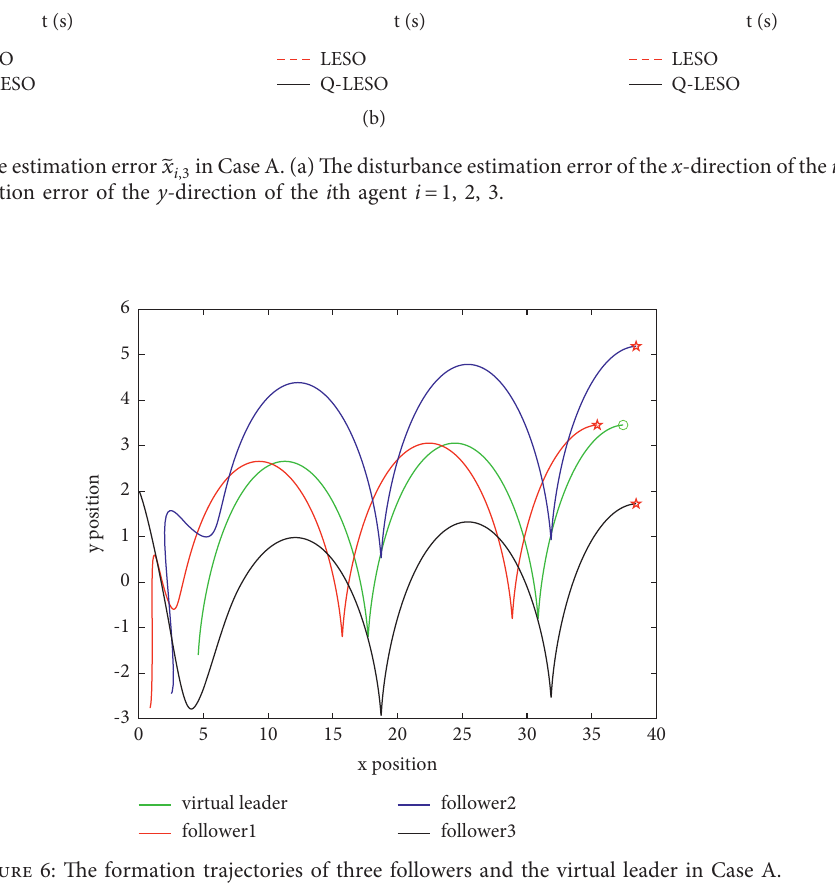
Figure 6: The formation trajectories of three followers and the virtual leader in Case A.